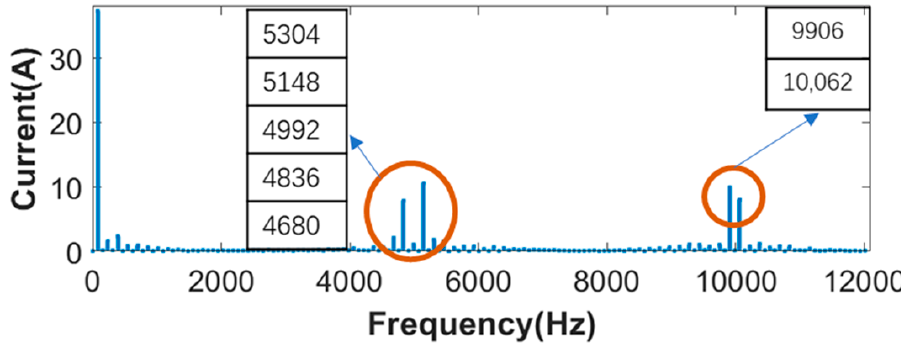
Figure 2. Simulation model of motor.